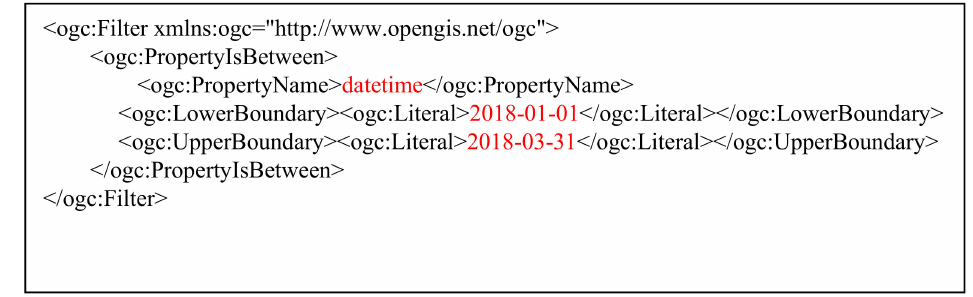
Figure 2. The result of time reasoning encoded according to the OGC Filter Specification.